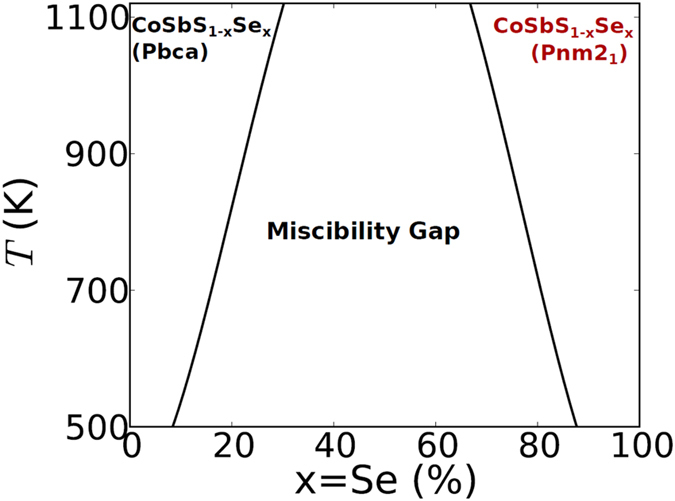
Temperature dependent phase diagram of CoSbS1−xSex.Theoretically considerations indicate a presence of a miscibility gap. The single phase region is constituted by CoSbS1−xSex(Pbca alloy) at low alloying concentrations and CoSbS1−xSex(Pnm21 alloy) at high alloying concentrations.